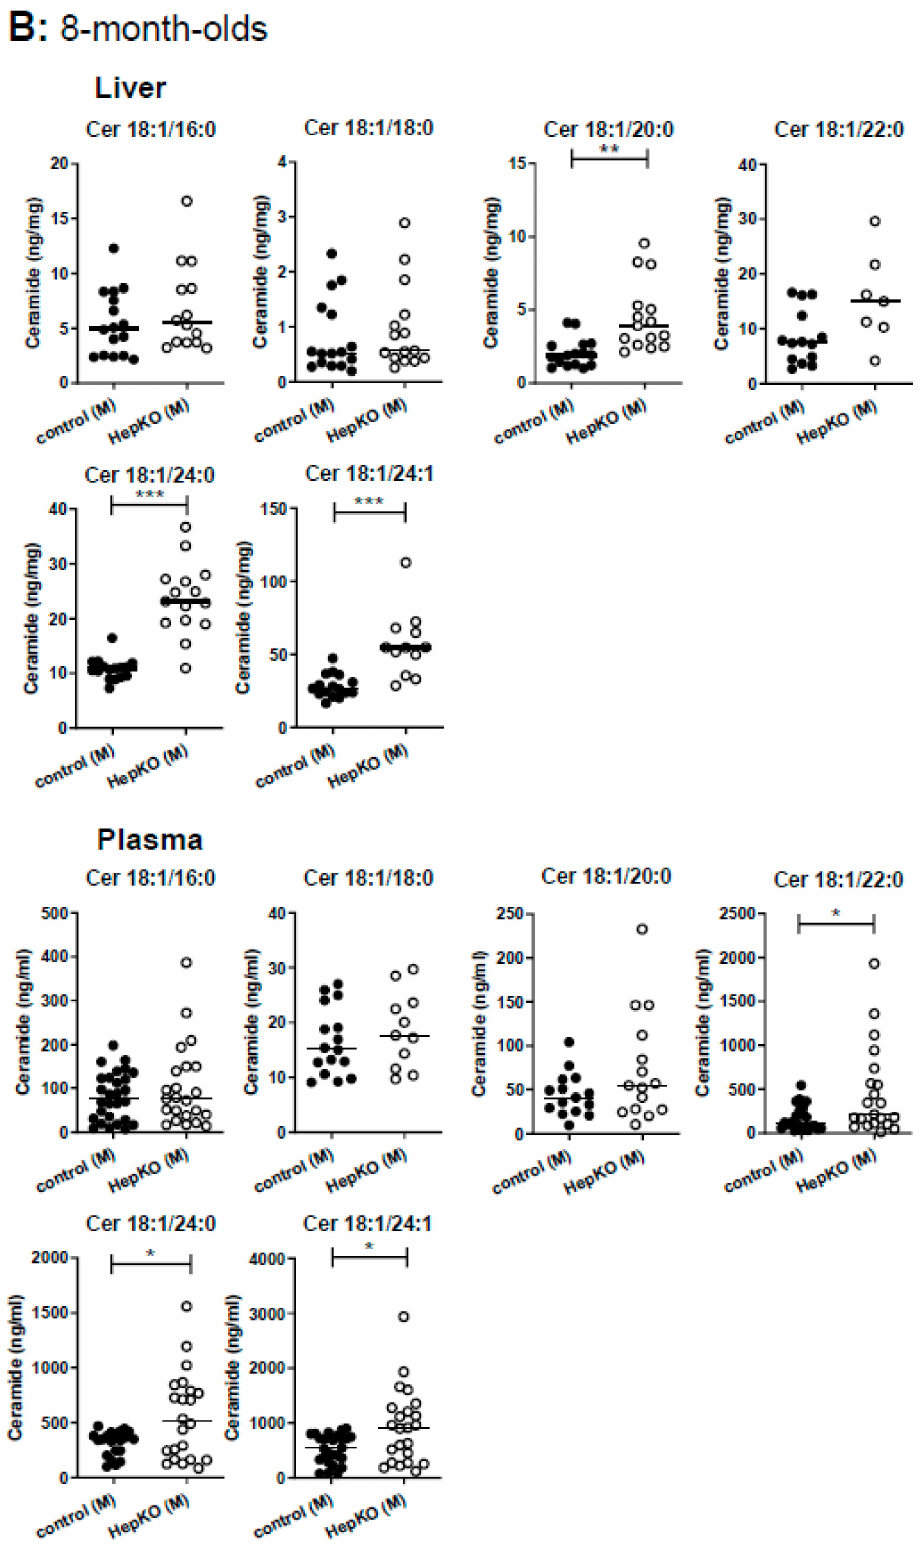
Figure 3. Levels of ceramides in liver and plasma of Sgpl1 HepKO mice. Ceramide (Cer) levels were measured by LC-MS/MS in liver and plasma of Sgpl1 control and Sgpl1 HepKO mice at the age of 8 weeks ( A ) or 8 months ( B ). Shown are values from individual mice and their median. * p < 0.05, ** p < 0.01, *** p < 0.001 in two-tailed Student’s t -test with Welch’s correction ( A , liver: n = 13–21; A , plasma: n = 4–24; B , liver: n = 7–16; B , plasma: n =